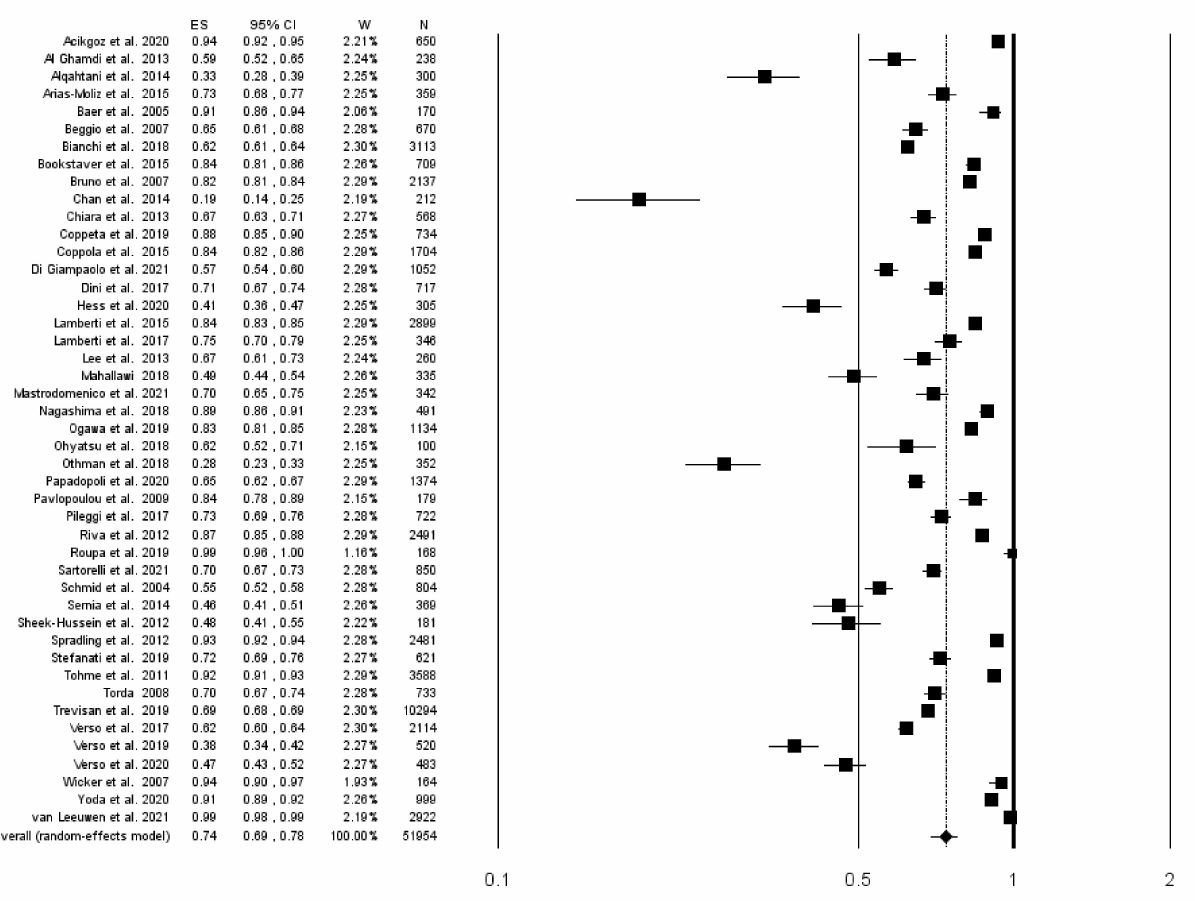
Figure 2. Forest plot of the prevalence of subjects with a serological correlate of protection (anti-HBs antibodies ≥ 10